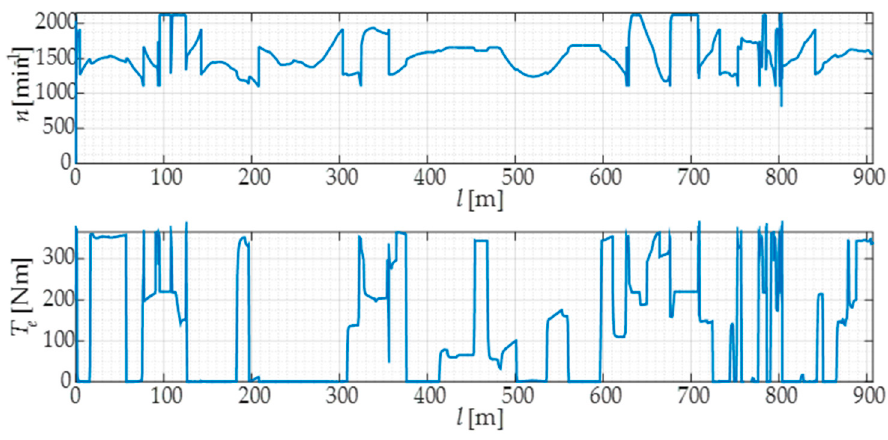
Figure 13. Engine speed and torque of conventional skidder for one driving scenario.